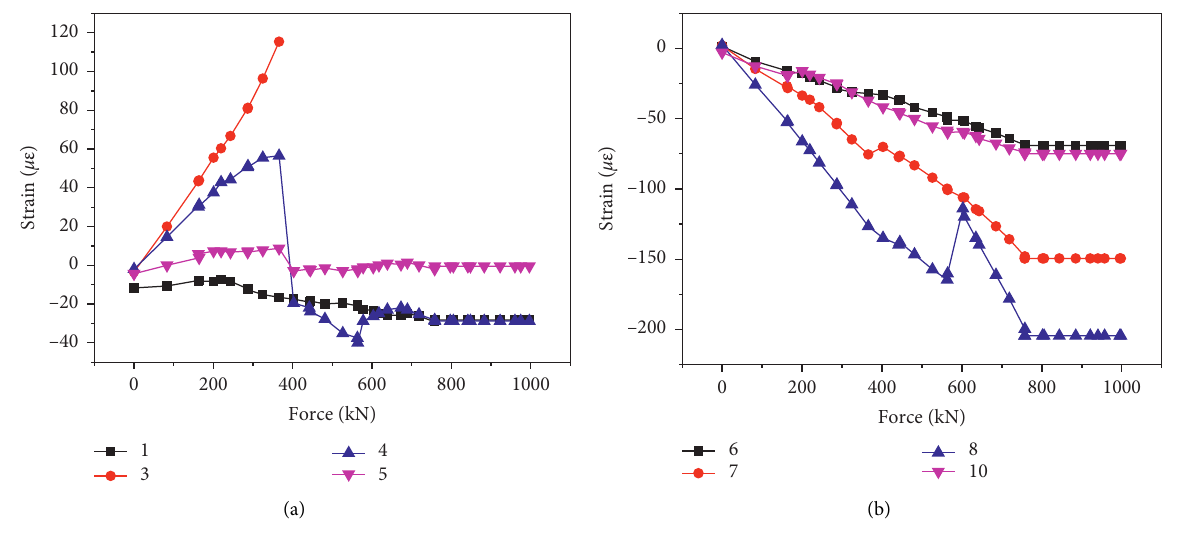
Figure 20: Load-strain curves of concrete fiber of SC-P2. (a) Lower fiber; (b) upper